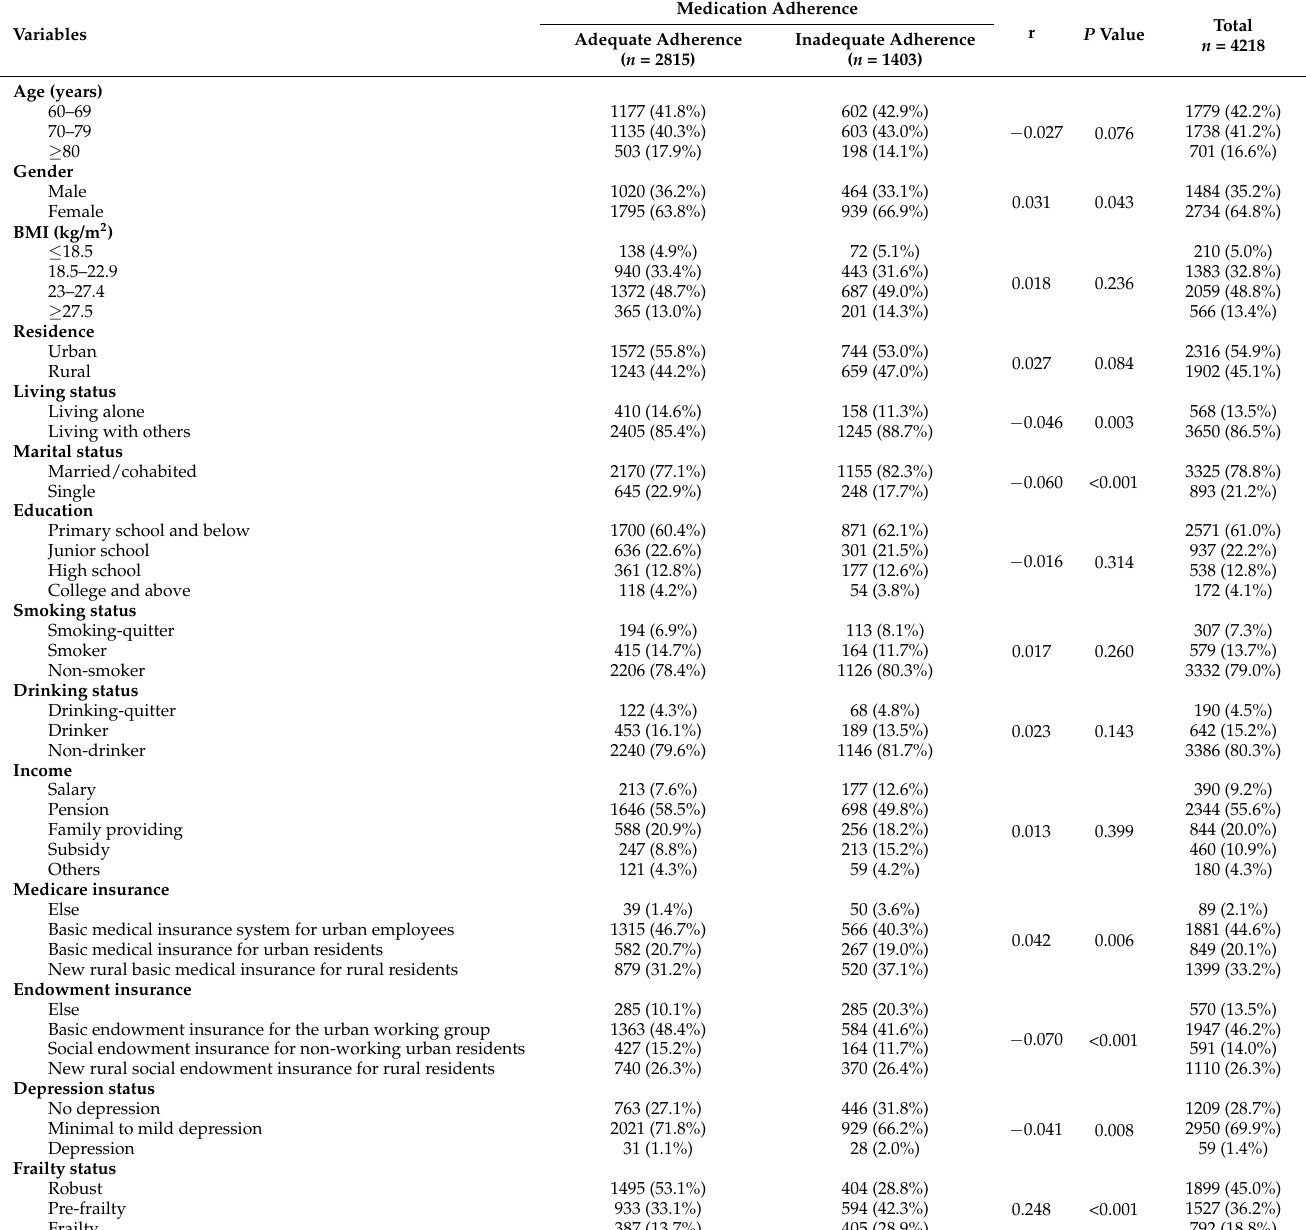
Table 1. Descriptive analysis results of participant characteristics ( n =